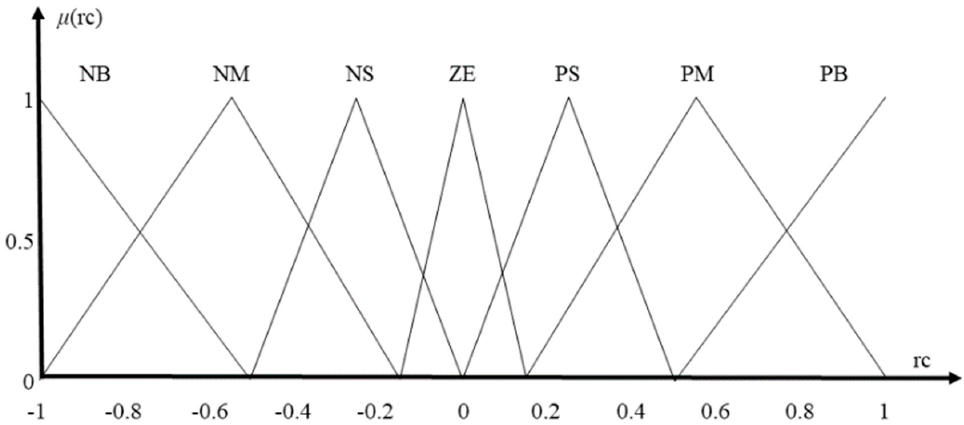
Figure 6. Output membership function. NB: Negative Big, NM: Negative Medium, NS: Negative Small, ZE: Zero; PB: Positive Big, PM: Positive Medium, PS: Positive Small. The rc value is obtained in Equation (10) using the center-of-gravity defuzzification method.